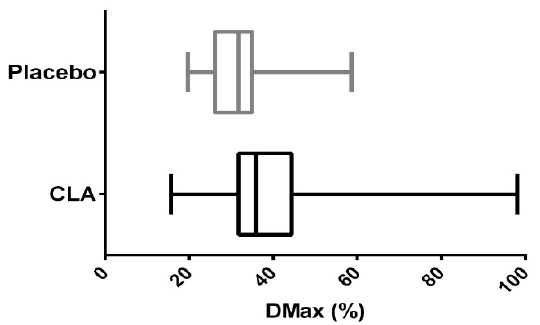
Figure 1. Maximum momentary 13 C recovery (Dmax) in subjects receiving conjugated linoleic acid (CLA) and placebo after 12 weeks of nutritional intervention ( p = 0.0076).